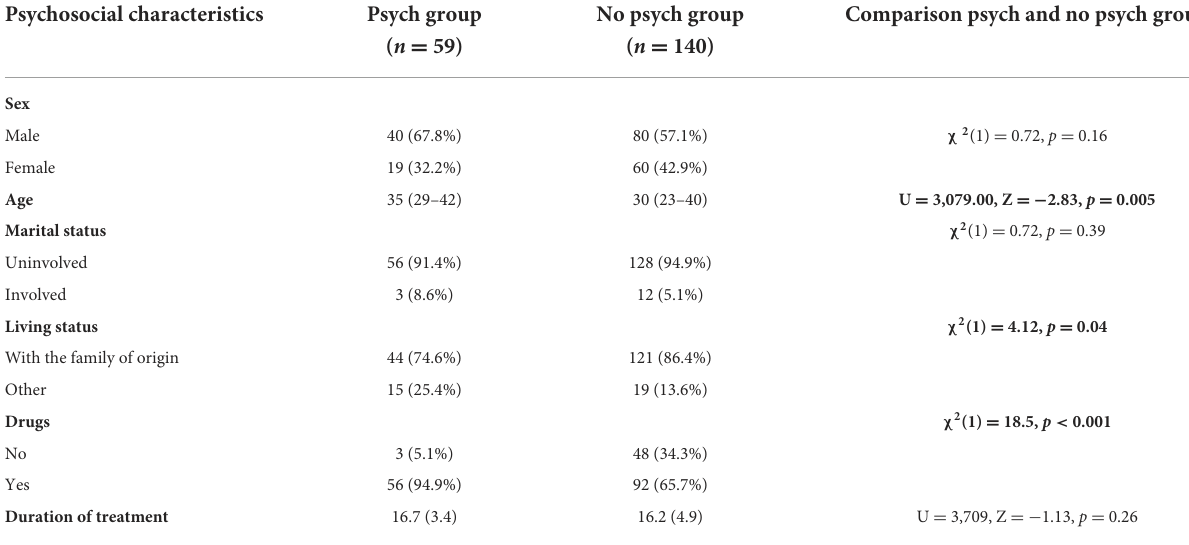
TABLE 1 Psychosocial characteristics (frequency and percentage) by the presence of psychiatric symptoms and results of comparisons between groups (the chi-square was used for discrete variables and the Mann-Whitney U test for continuous variables). Psychosocial characteristics